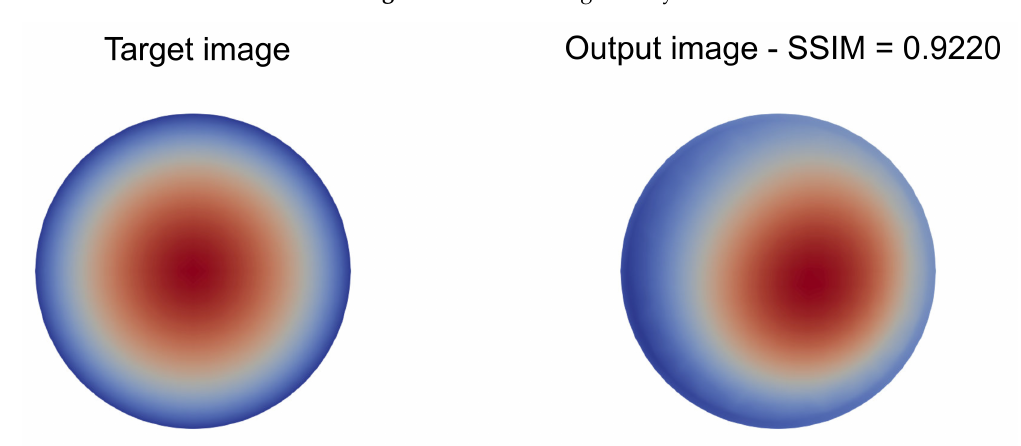
Figure 7. Static mixer geometry.